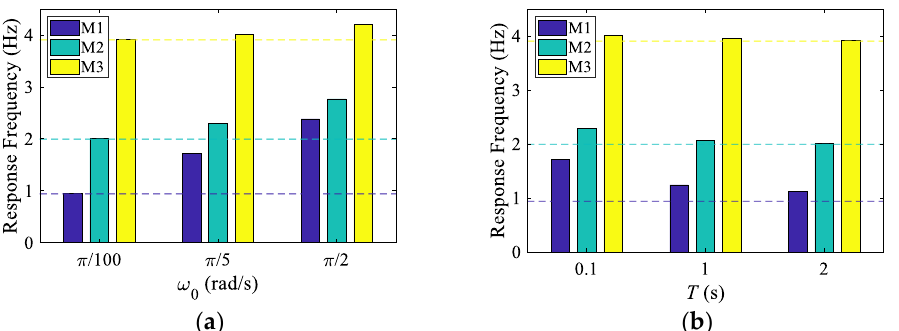
Figure 12. Relationship between response frequency and rigid body motion of different models. ( a ) T = 0.1 s with different ω 0 ( b ) ω 0 = π/5 (rad/s) with different T.